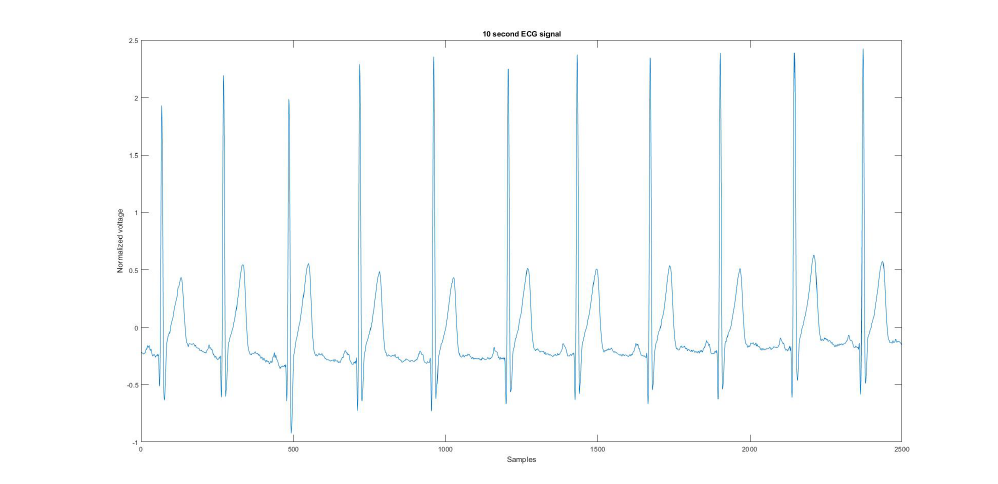
Figure A21. The reference signal from the Vivalnk ECG device.